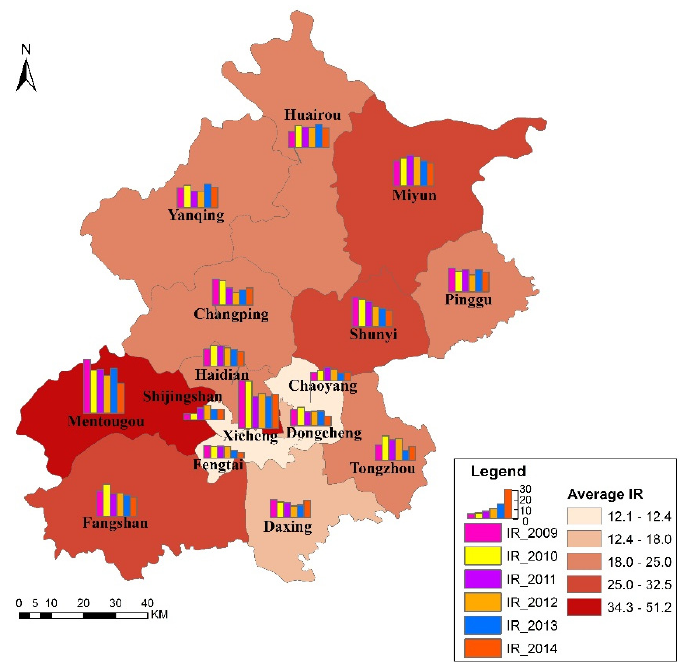
Figure 2. Map of the IRs and average IRs of TB from 2009 to 2014 at the district level in Beijing.